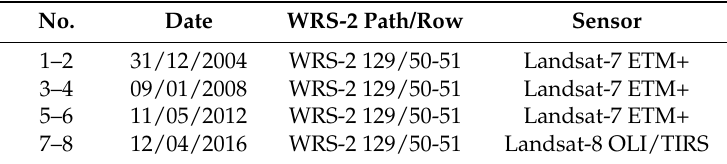
Table 1. Landsat scenes used for Land Use and Land Cover (LULC) maps. WRS = Worldwide Reference System.